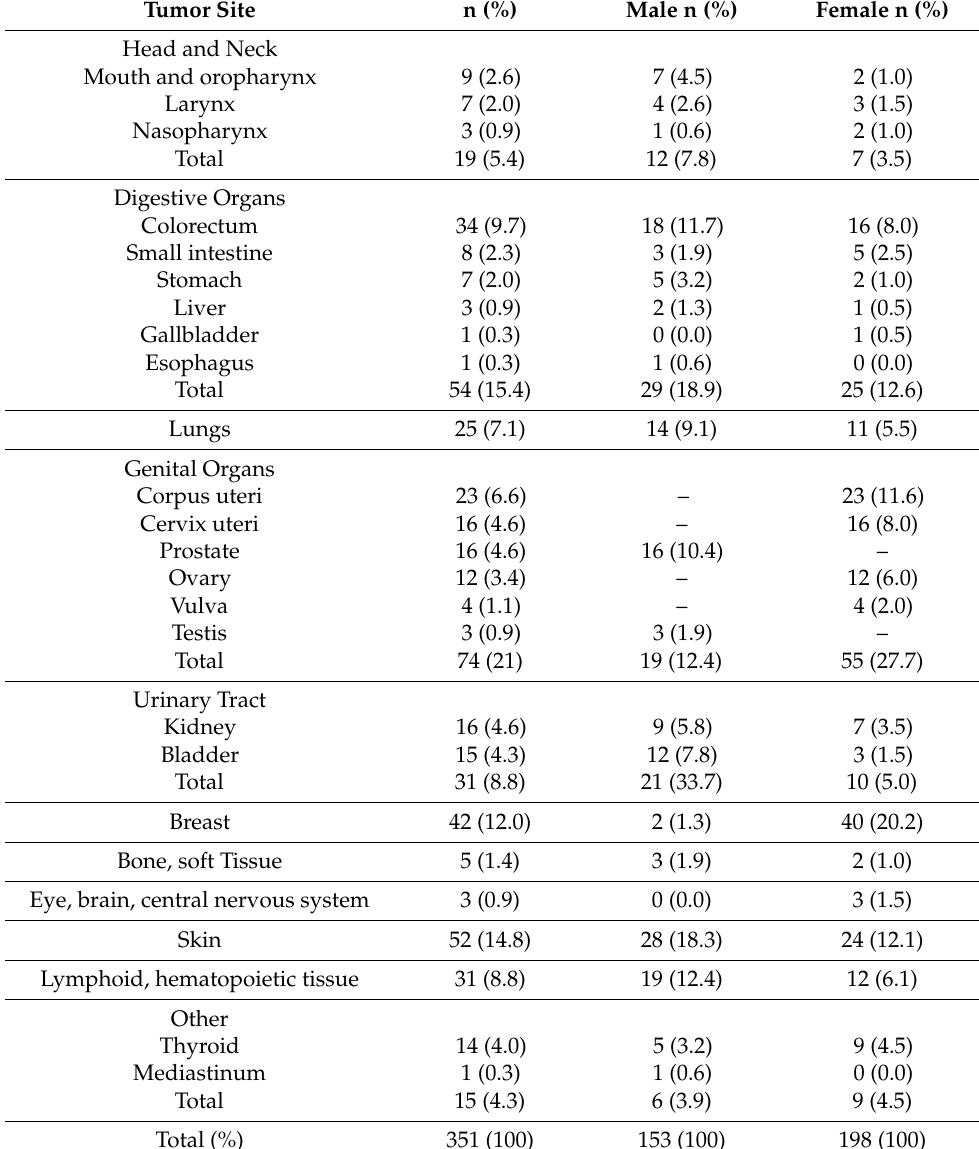
Table 7. Tumor site distribution based on gender–the expanded